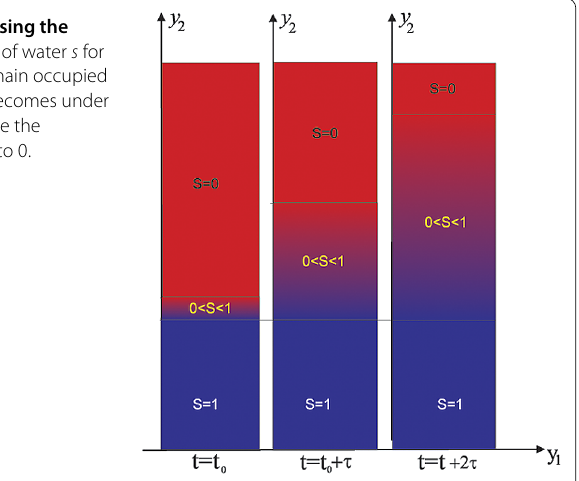
Figure 3 Homogenization by increasing the number of capillaries. Concentration of water s for increasing times (left to right). The domain occupied by the water tongues at a fixed time becomes under homogenization a mushy region, where the concentration s of water varies from 1 to